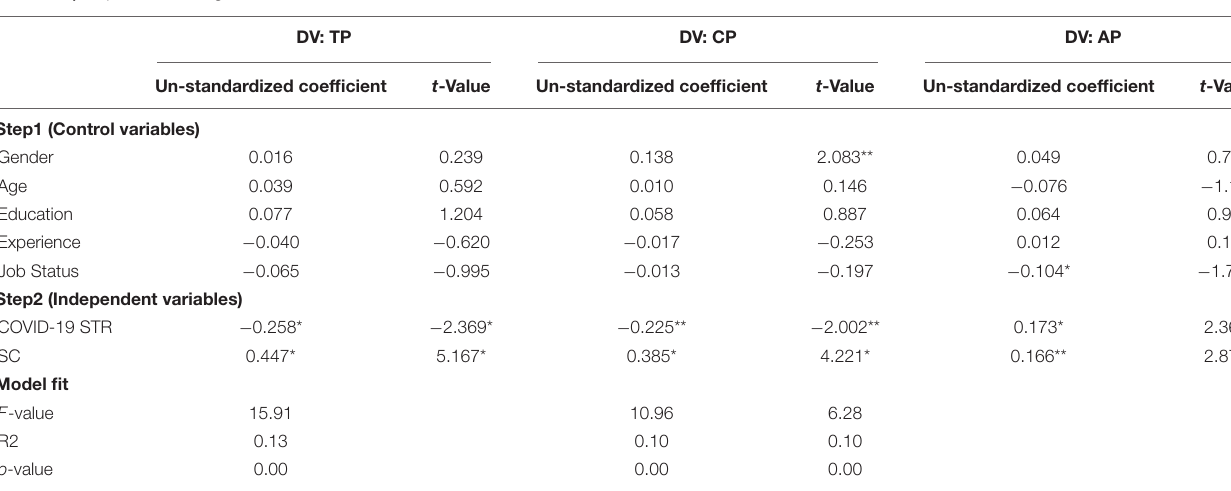
TABLE 4 | Stepwise linear regression.